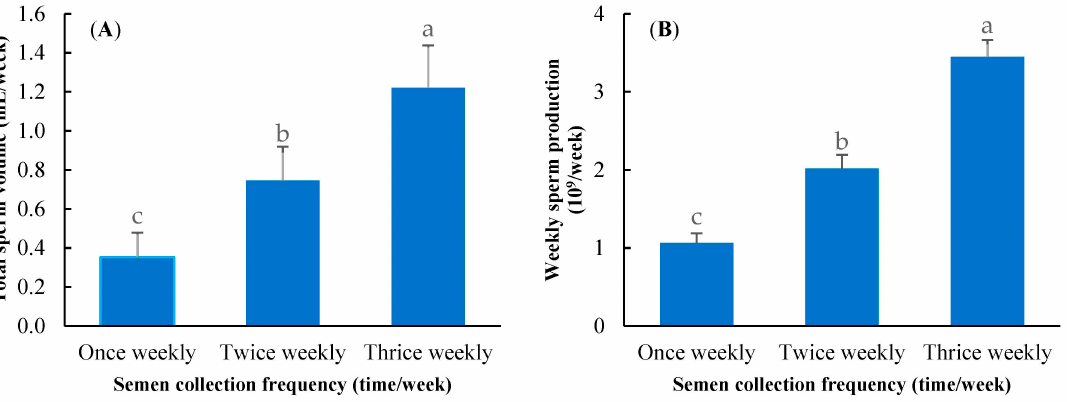
Figure 2. Effect of semen collection frequency on total sperm volume ( A ) and weekly sperm pro- duction ( B ); a, b, c: means followed by different letters differ significantly among semen collection frequencies at p < 0.01.